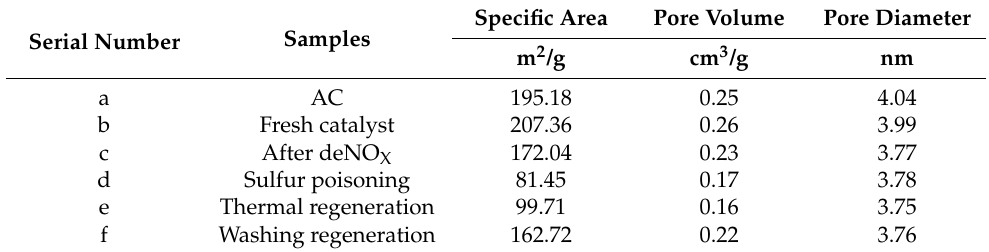
Table 1. Specific surface area and pore size analysis.